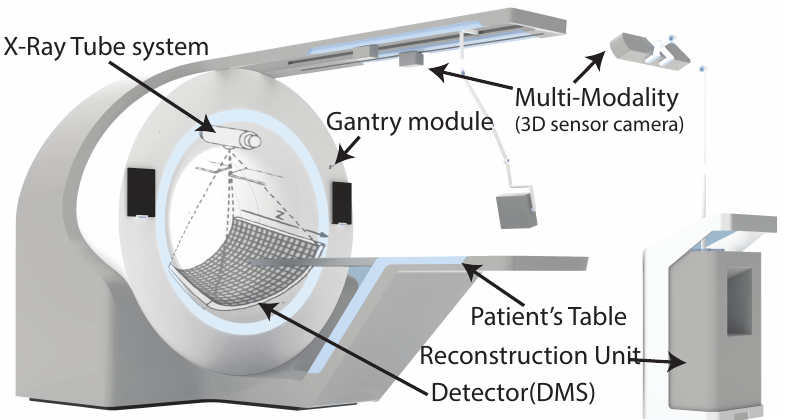
Figure 1. CT scanner components. Reprinted/adapted with permission from Ref. [18]. Copyright 2019,